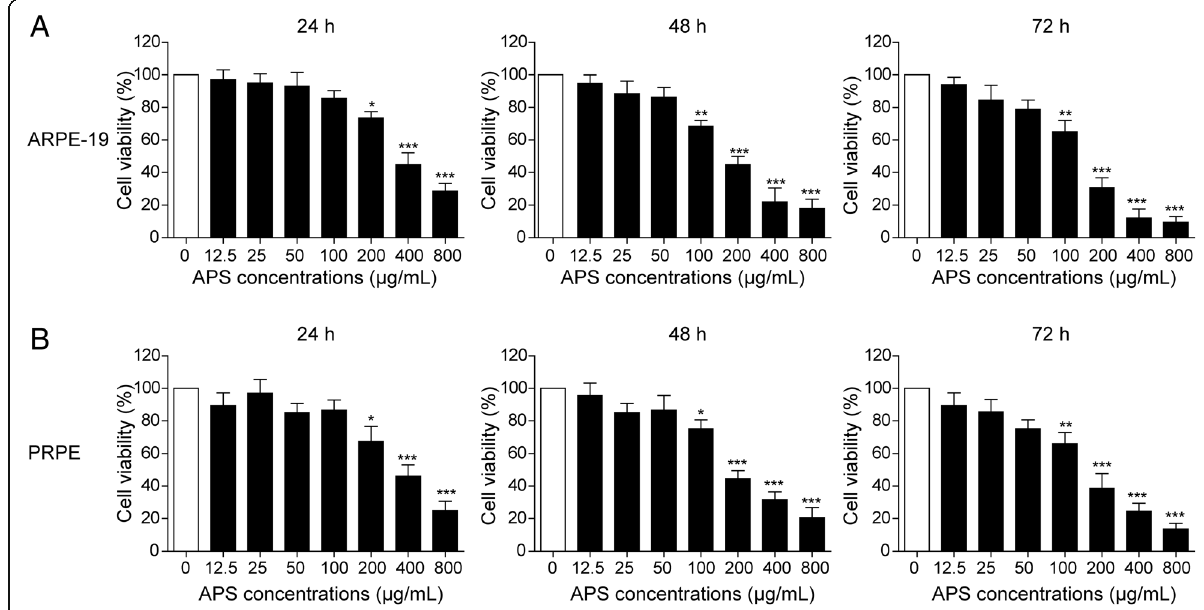
Fig. 1 The effects of APS on the survival of retinal pigment epithelium cells. a Different dosages of APS were applied to treat the cultured RPE cell line (ARPE-19) for different time course. b Different dosages of APS were applied to treat the cultured primary RPE cells (PRPE) for different time course. Error bars represented mean ± SD. *** p < 0.001, ** p < 0.01, * p <